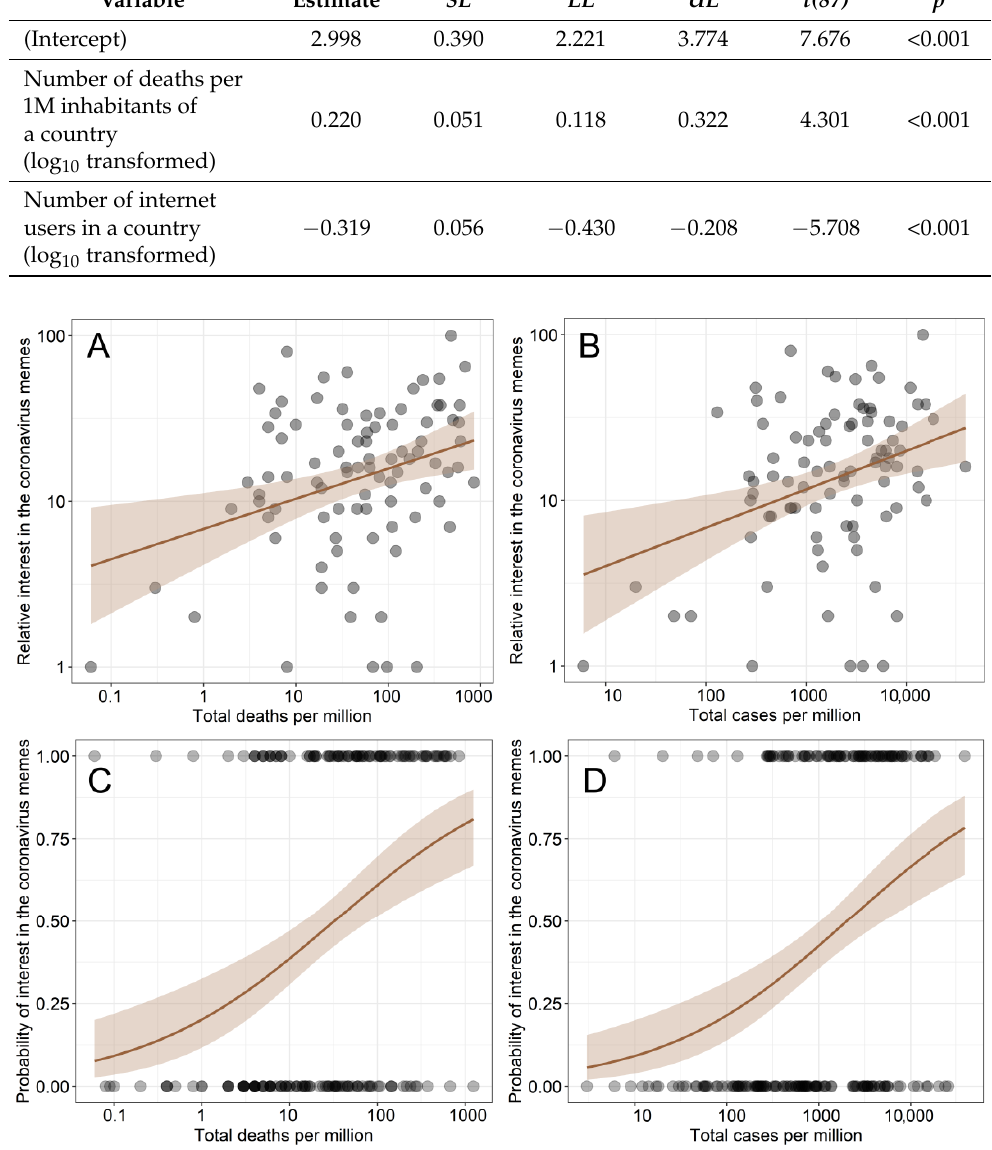
Figure 3. The associations between the interest in coronavirus memes and real coronavirus statistics in different countries. The relative interest (measured as the Google Trends index) in coronavirus memes (search string: “coronavirus meme”) in different countries and its relation to ( A ) total number of deaths due to COVID-19 per one million inhabitants of a given country and ( B ) the total number of cases per one million inhabitants. The probability of occurrence of interest in coronavirus memes in different countries in relation to ( C ) the total number of deaths due to COVID-19 per one million inhabitants of a given country and ( D ) the total number of cases per one million inhabitants. For ( A , B ), a linear regression was fitted with a 95% confidence interval, and for ( C , D ), a GLM with binomial error distribution was fitted with a 95% confidence interval. The data points are transparent for better visibility of the overlapping values. Table 3. Results of the GLM testing the association between the occurrence of interest in coronavirus memes (Google Trends index) and total number of deaths due to COVID-19 per one million inhab- itants and percentage of internet users in different countries. Odds ratio (OR) with 95% confidence intervals (LL – lower confidence intervals, UL – upper confidence intervals) and Wald z – test (with re- sidual degree of freedom). Model explained 33% variation in data (McFadden pseudo- R 2 ). Variable OR UL z(186)